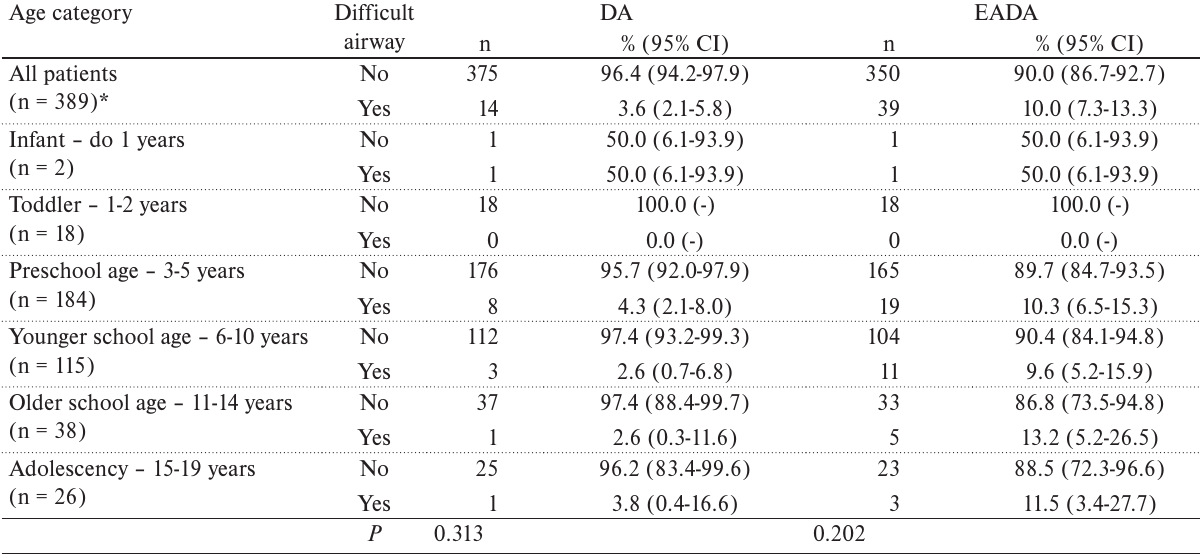
Table 2. Difficult airway (DA) and Events associated with difficult airway (EADA) incidence according to the age category. Age category